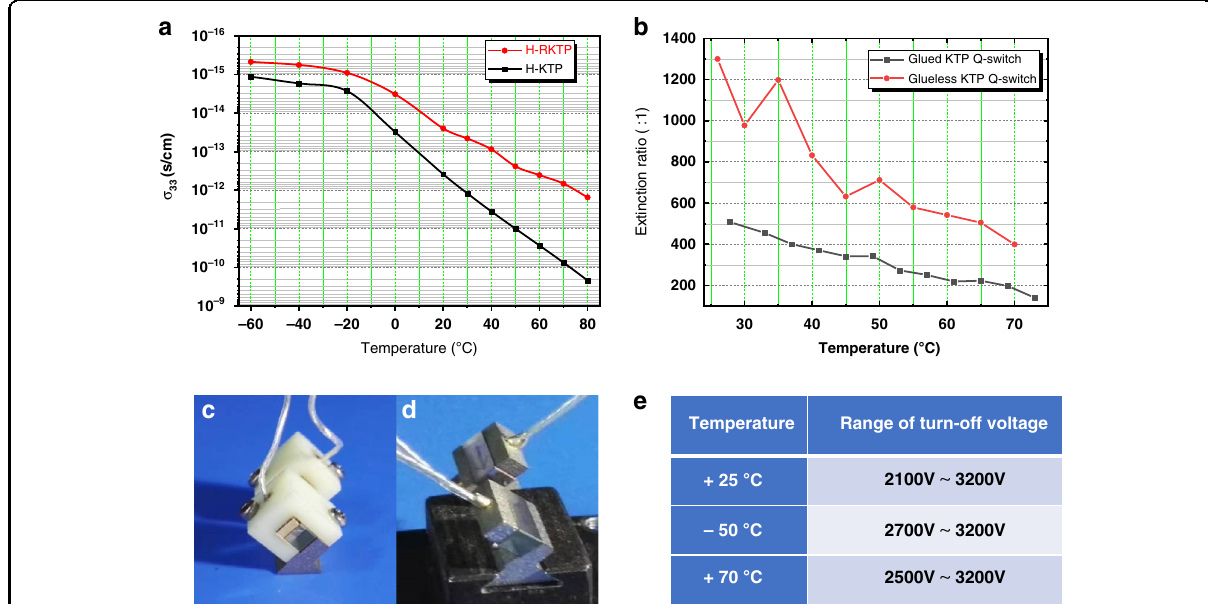
Fig. 12 Extinction ratio and thermal effect of the EO modulation based on KTP crystal. a Temperature dependence plot of DC conductivity in the range from − 60 °C to + 80 °C; b Variation of the extinction ratio of EO switches with different con fi gurations from room temperature to ~70 °C: glueless ( c ) or glued ( d ); e EO switch turn-off voltage range at room temperature, low temperature ( − 50 °C) and high temperature (70